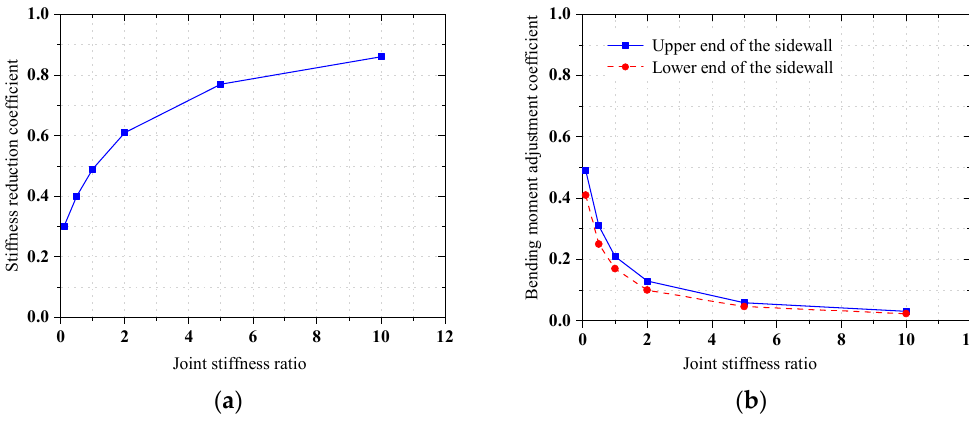
Figure 5. Influence of joint stiffness ratio: ( a ) stiffness reduction coefficient and ( b ) bending moment adjustment coefficients.